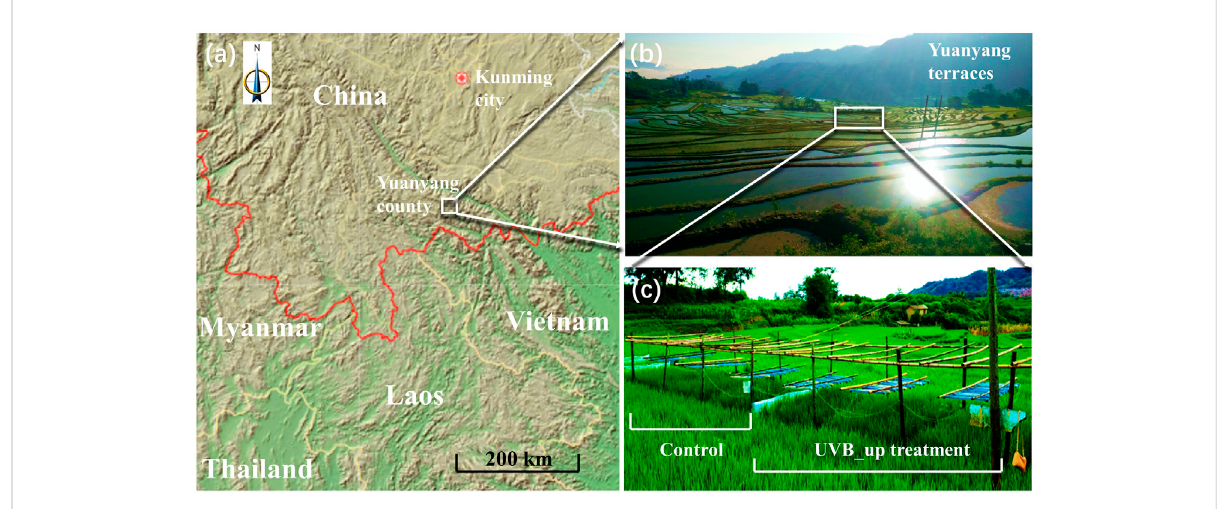
FIGURE 1 Topographical map and the location of Yuanyang County (A) ; photos of Yuanyang Terraces (B) and in situ fi eld experiments (C) . Control: treatment under natural conditions; UVB_up: treatment under enhanced UV-B radiation.